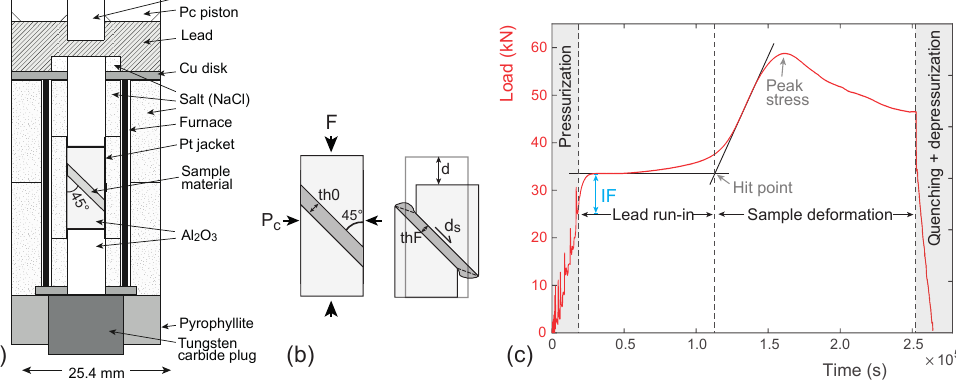
Figure A1. General shear experiments. (a) Sample assembly in cross section. (b) Schematic sample cross section at the start of experiment (left) and after sample deformation (right). F : load induced by load piston, Pc: confining pressure, d : axial displacement, ds: shear displace- ment, th0: shear zone thickness at start, thF: shear zone thickness at end of experiment. (c) Phases of an experiment; red line: load F(t) . During “pressurization”, the sample is brought to the desired Pc– T conditions. Black dot denotes the start of experiment. IF: initial load in- crease caused by machine friction. Phase 1: “lead run-in”; the sample is not loaded. Phase 2: sample supports load and deforms. “Hit point” denotes the onset of sample loading. During “quenching + depressurization”, the load is released and the temperature brought to ambient